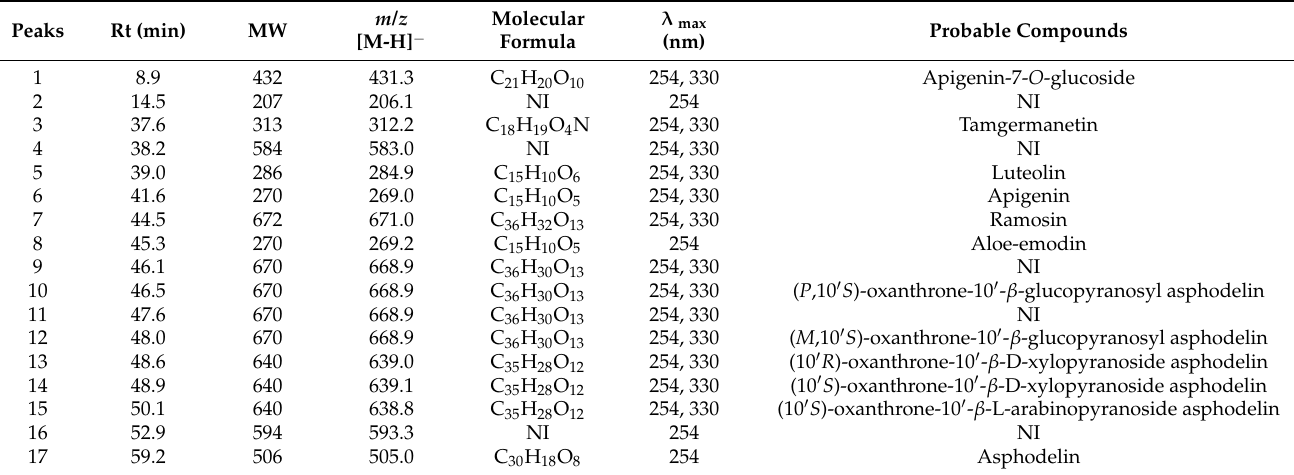
Table 2. Phenolic profile by LC-ESI/MS analysis in negative ion mode of compounds 1 – 17 from CHE. Rt, retention time of the peaks detected in the chromatogram reported in Figure 1. NI = not identified.